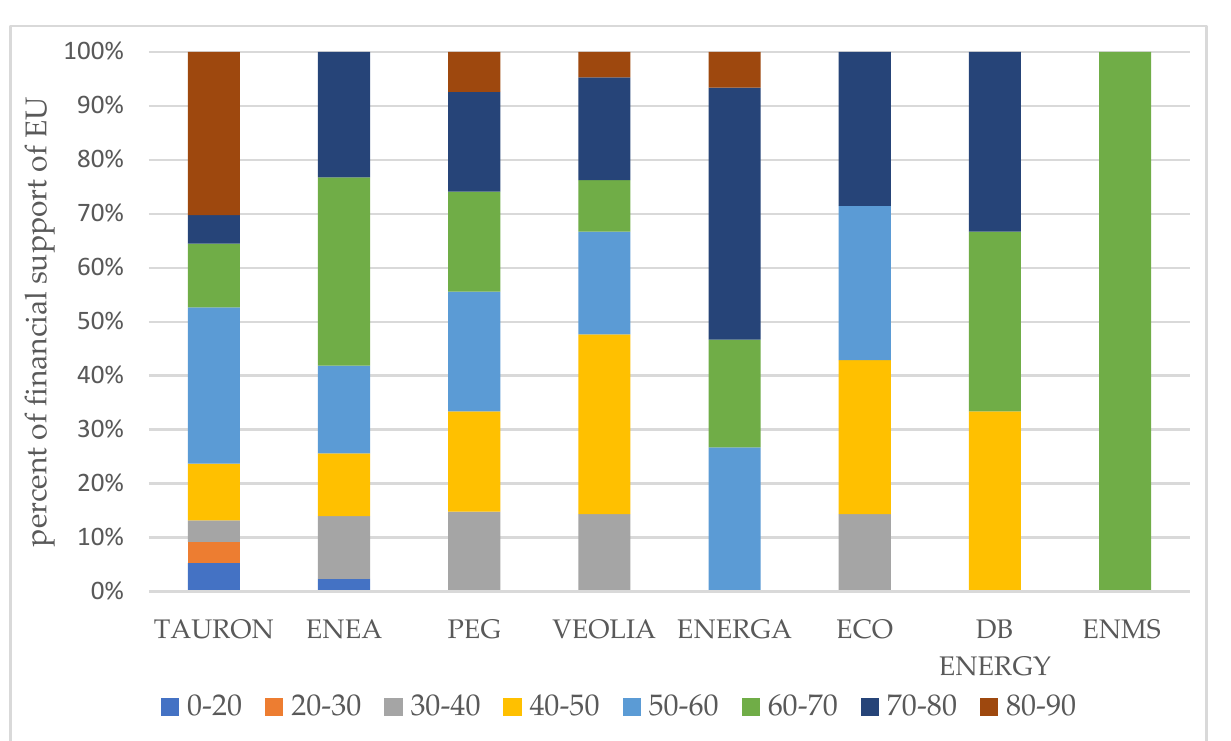
Figure 3. Number of projects implemented by individual energy companies, specifying the level of financing from European funds (% of funding) (distinguished intervals of EU financial support: 0-20, 20-30, 30 - 40, 40-50, 50-60, 60-70, 70-80 [%]). Source: own compilation based on data from